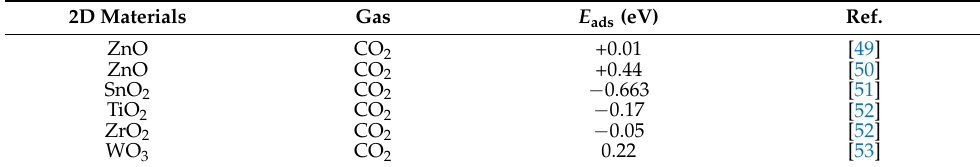
Figure 1. Geometric structures of the GeSe monolayer ( a , e ), the MoS 2 –GeSe monolayer ( b , f ), the CO 2 /MoS 2 –GeSe monolayer ( c , g ) and CO 2 ( d ). The red circle is MoS 2 unit. Table 1. The E ads values of different materials. Table 1. The E ads values of different materials.